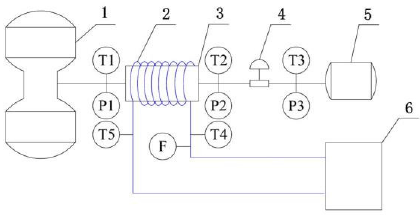
Figure 1. Schematic diagram of the experimental apparatus (1—Linear compressor; 2—Cooling water loop; 3—Testing section; 4—Adjusting valve; 5—Reservoir; 6—Thermostat).